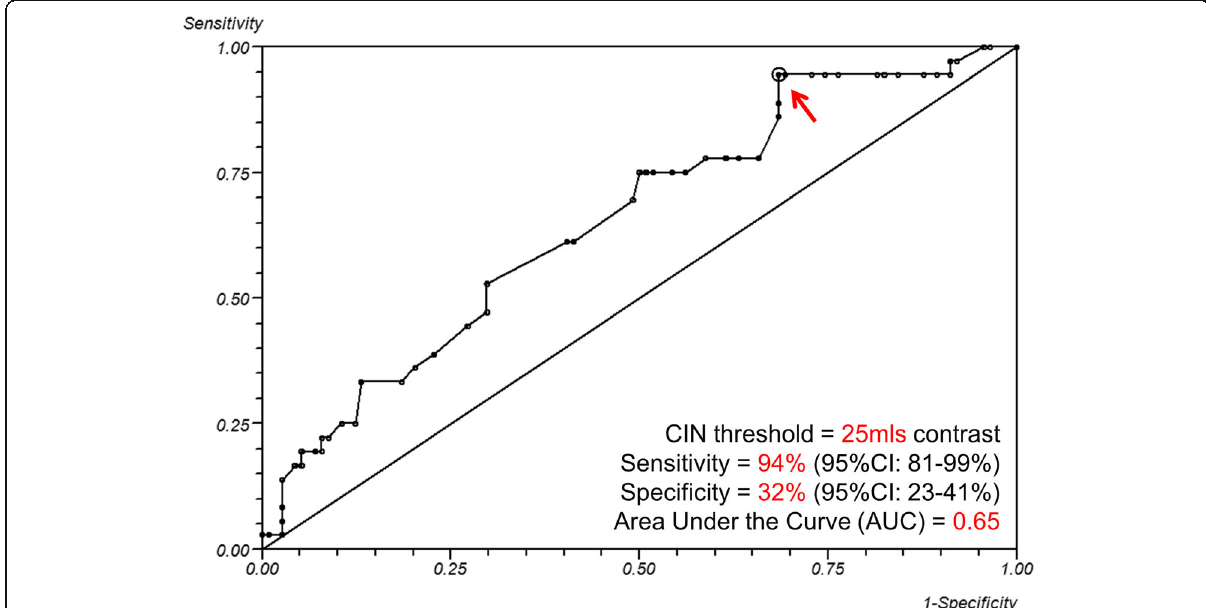
Fig. 3 ROC curve of the volume of iodinated contrast. CIN cut-off value was 25mls of volume of iodine CM in predicting development CIN. [Sensitivity = 94.4% (95% CI: 81 – 99%), Specificity = 32% (95% CI: 23 – 41%), Area Under the Curve (AUC) =